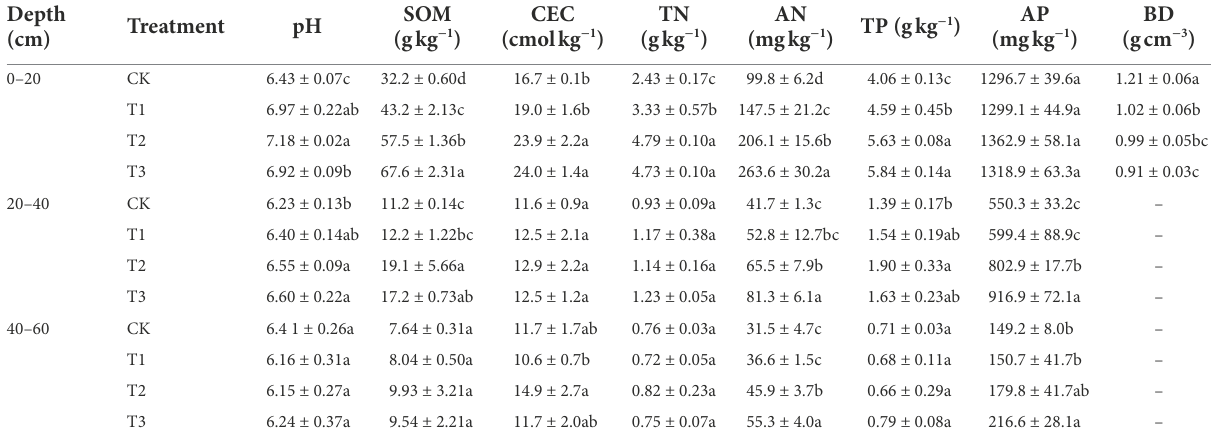
TABLE 2 Effects of compost application on soil properties (mean ± SD, n = 3). Depth